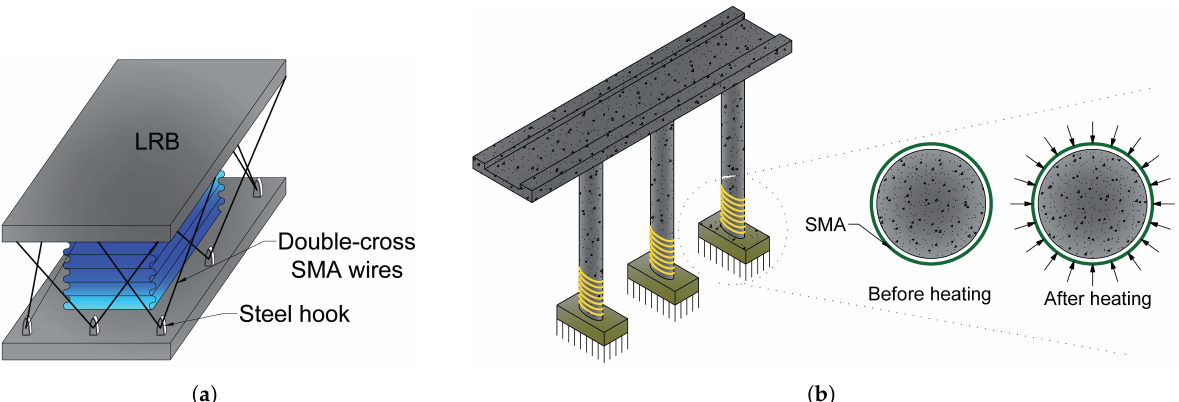
Figure 13. ( a ) SMA wire-based lead rubber bearing [66]; ( b ) The system of utilising external confining loading on RC bridge columns